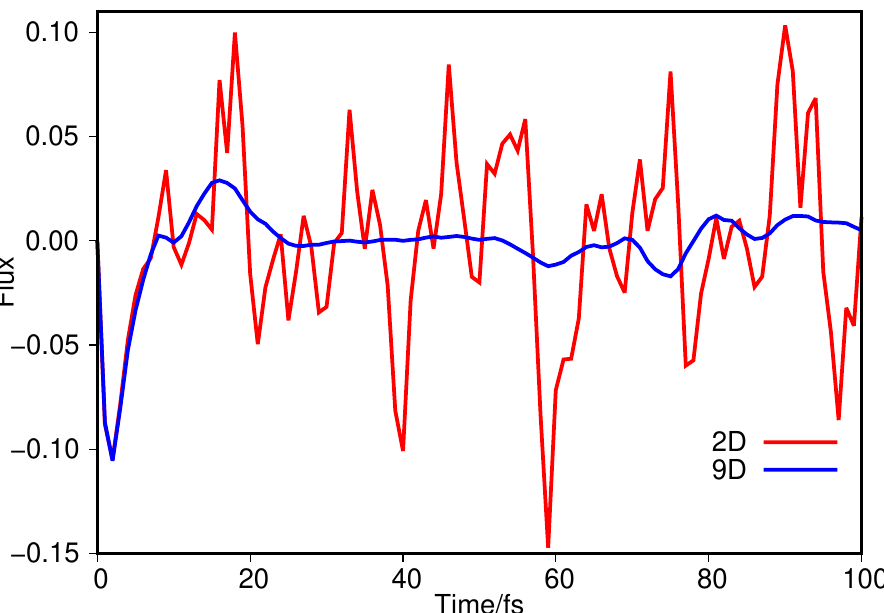
Figure 4. Wavepacket flux over the hydrogen transfer transition barrier in salicylaldimine as a func- tion of propagation time. The solid, red line is the flux seen during dynamics in 2 dimensions whilst the dashed, blue line is that given when using the 9 normal modes listed in the